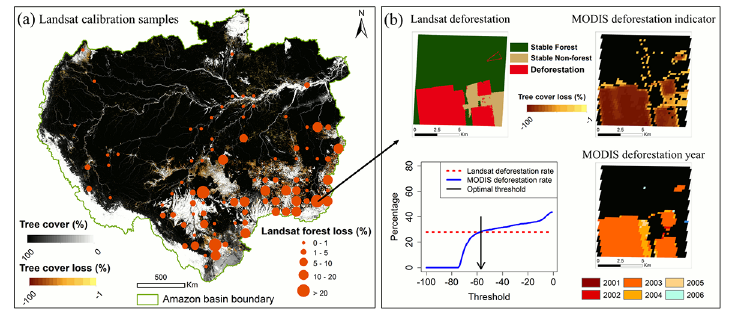
deforestation rates of Landsat sample blocks. (b) An example of Landsat deforestation, MODIS deforestation indicator, the optimal threshold and the resulting MODIS deforestation year